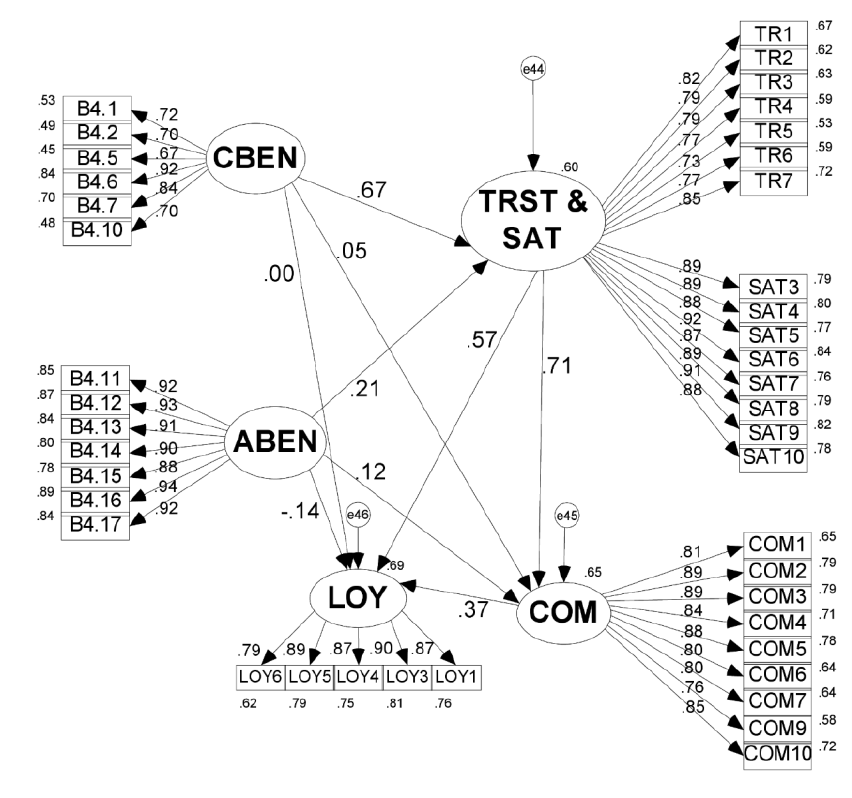
Figure 3: Structural Model ; Source :